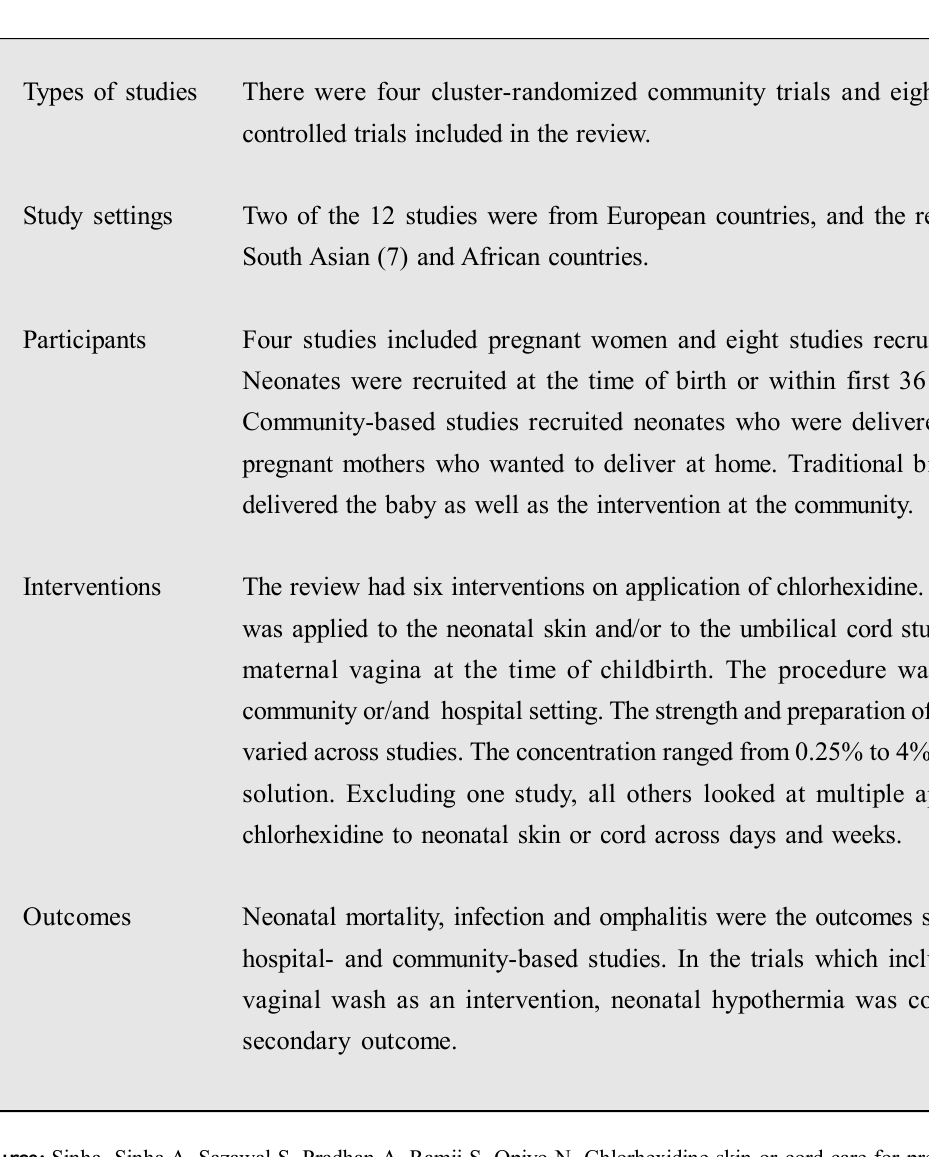
Box 1: Summary of the evidence collated in Cochrane